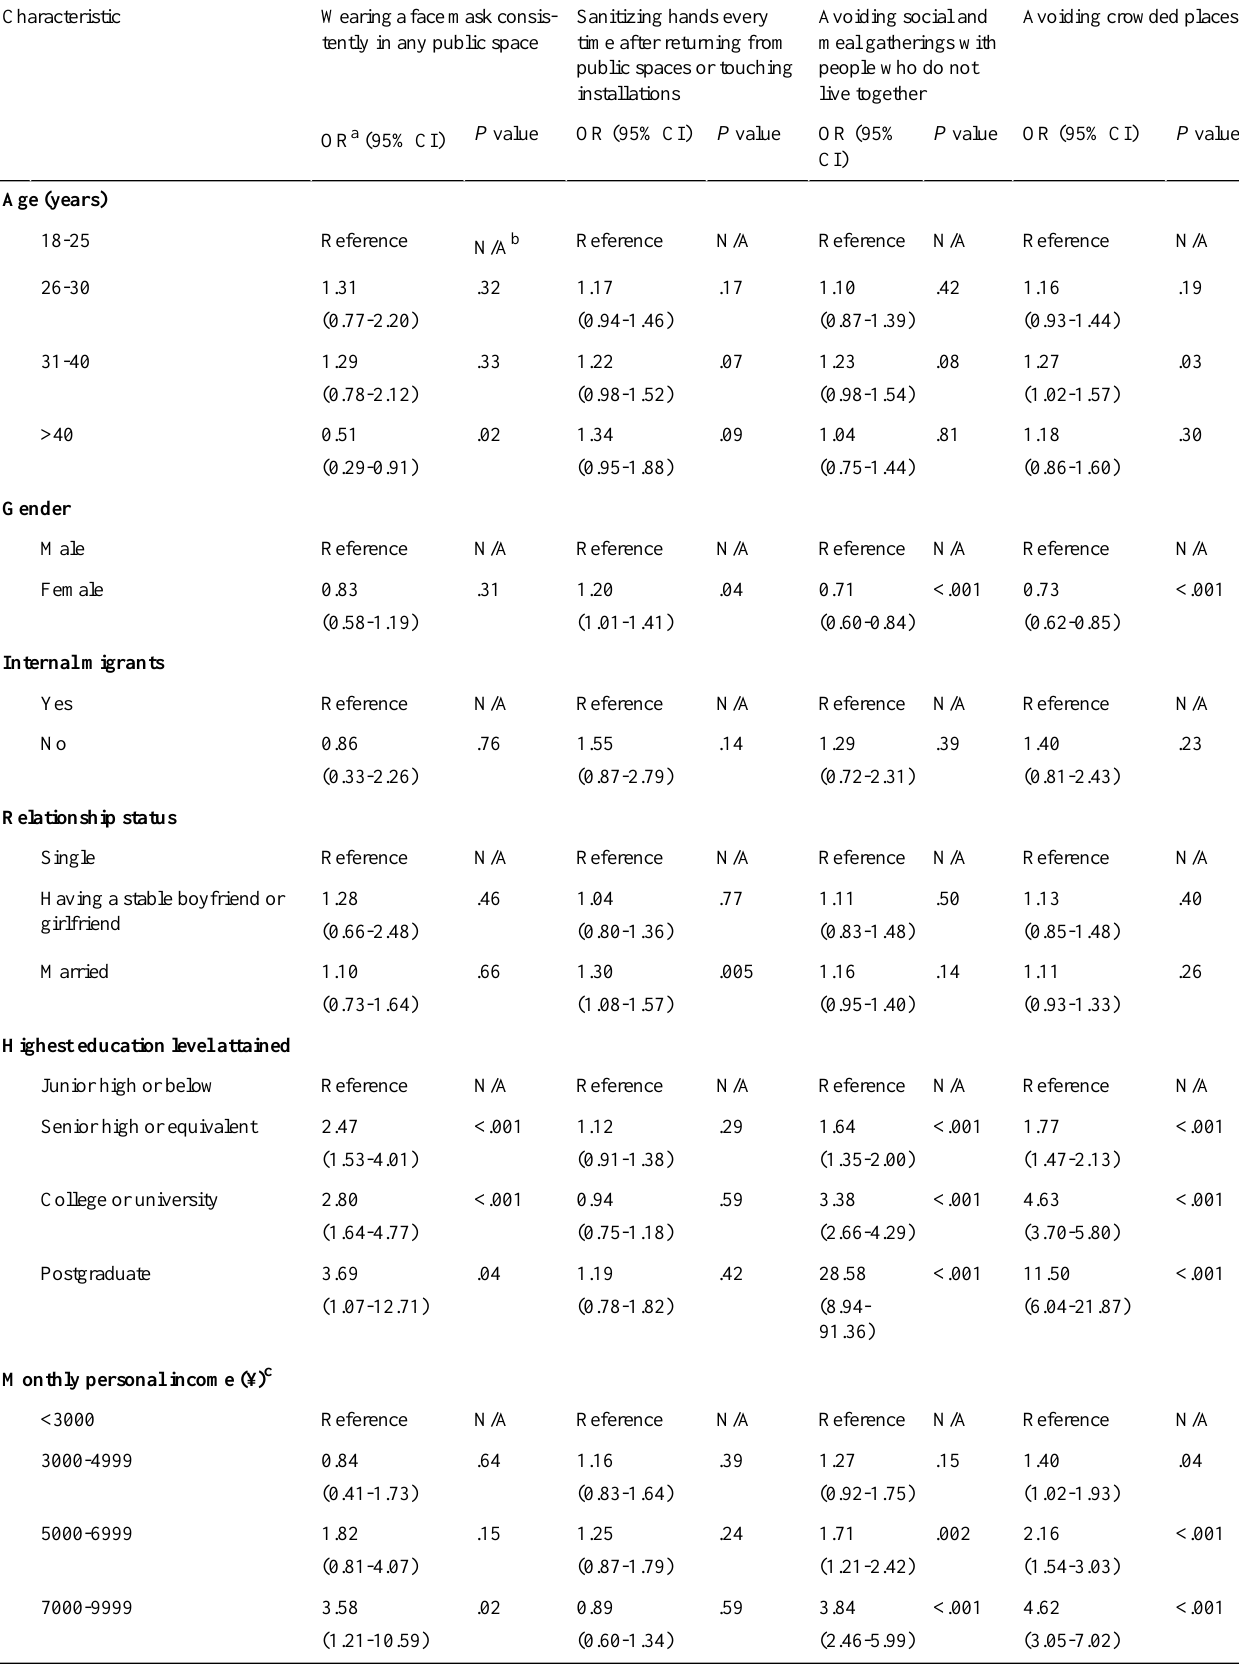
Table 6. Associations between background characteristics and self-reported compliance with different personal preventive measures.